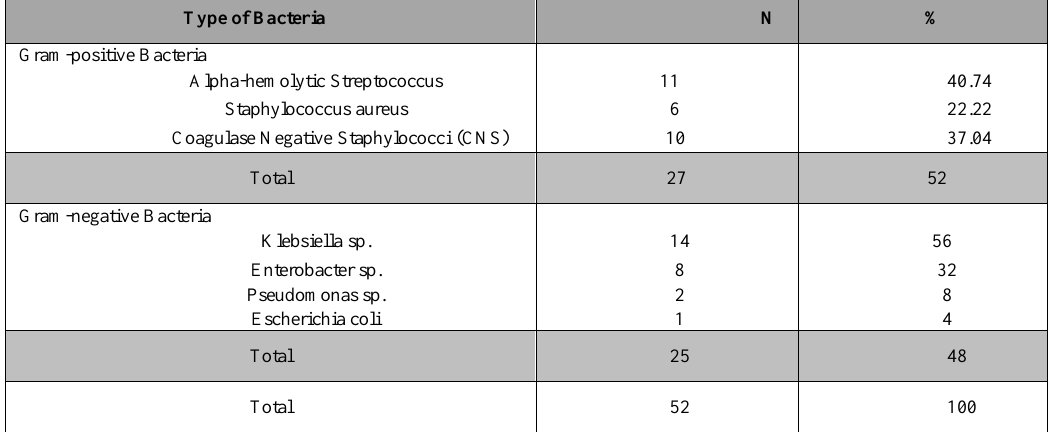
Table 3. Aerobic bacterial pattern on odontectomy